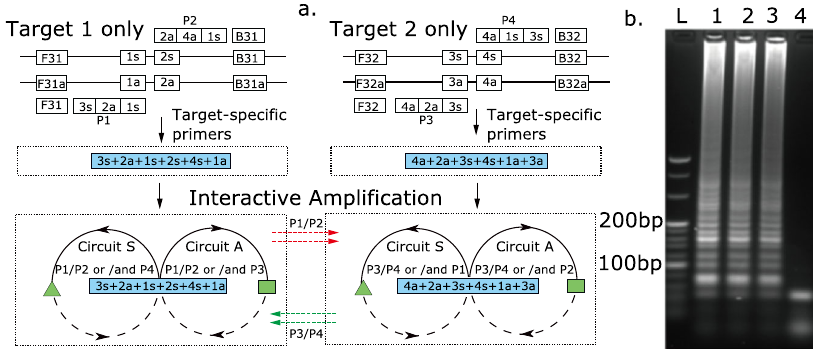
Fig. 4 Multiplexed ampli fi cation of two HIV gene regions with cross-priming strategy. a Reaction graph. The primers P1-4 allow cross-ampli fi cation of 2 pathways (see Supplementary Fig. S8 for detailed functional motifs). b Agarose gel electrophoresis of the ampli fi ed products. Lane L — 25 bp ladder; Lane 1 — target 1, lane 2 — target 2; lane 3 — both targets 1 and 2; lane 4 — no target. The gel is representative of experiments repeated independently three times with similar results. Supplementary Fig. S8 also shows the results of the sequencing of the ampli fi cation. Source data are provided as a Source Data fi le.